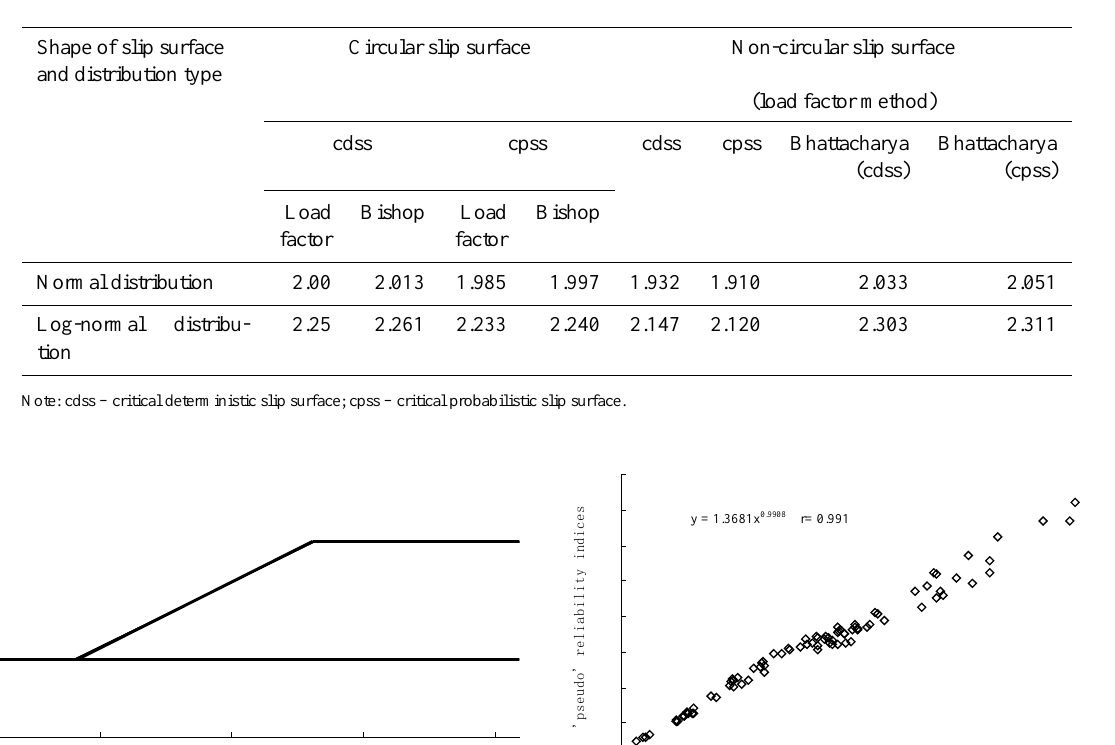
Table 5. Summary of reliability indices for the problem in Fig. 10.